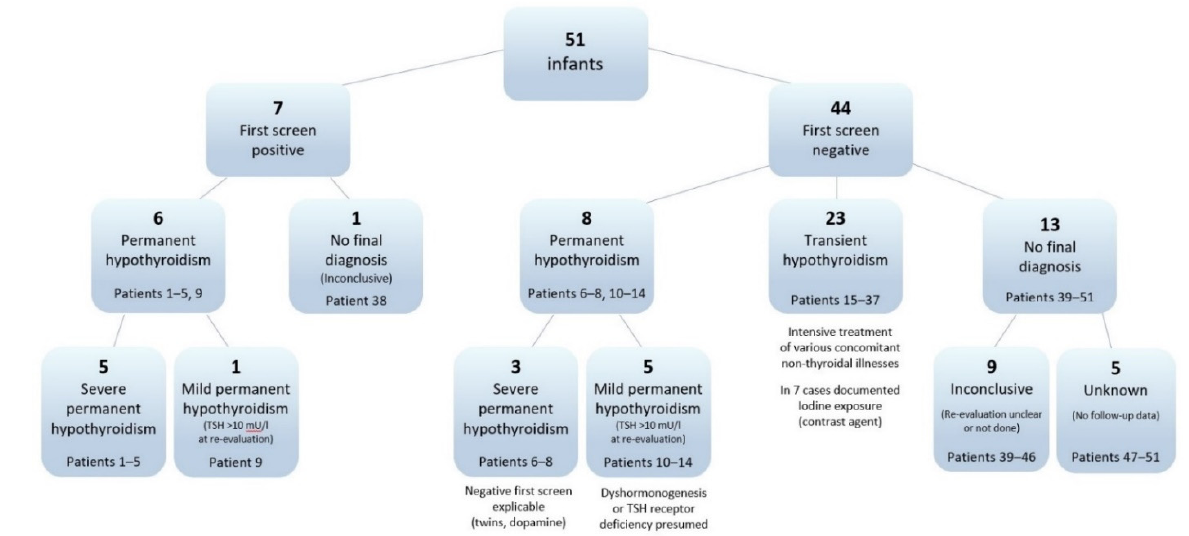
Figure 1. Overview of first screen results and final diagnoses. Table 1. Main population characteristics and